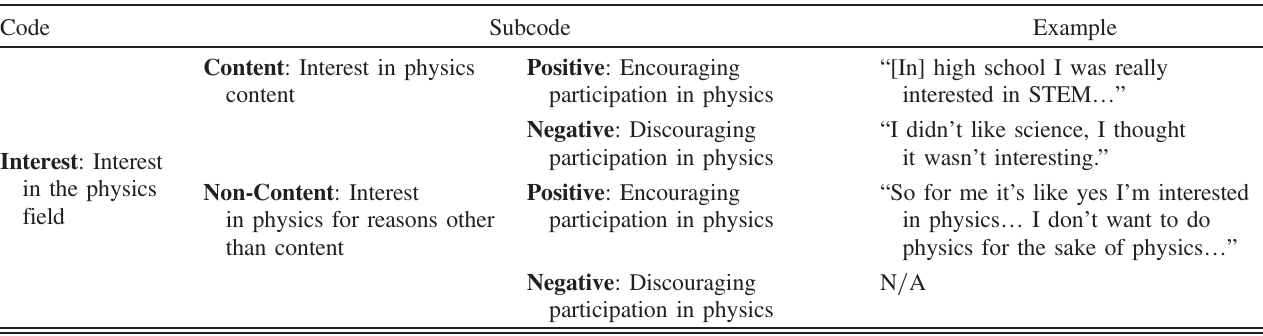
TABLE V. Details of our interest construct code definitions. This includes the definition of the main construct, as well as the definitions of each subcode and example from the interviews of Cara, Jeff, Cindy, or